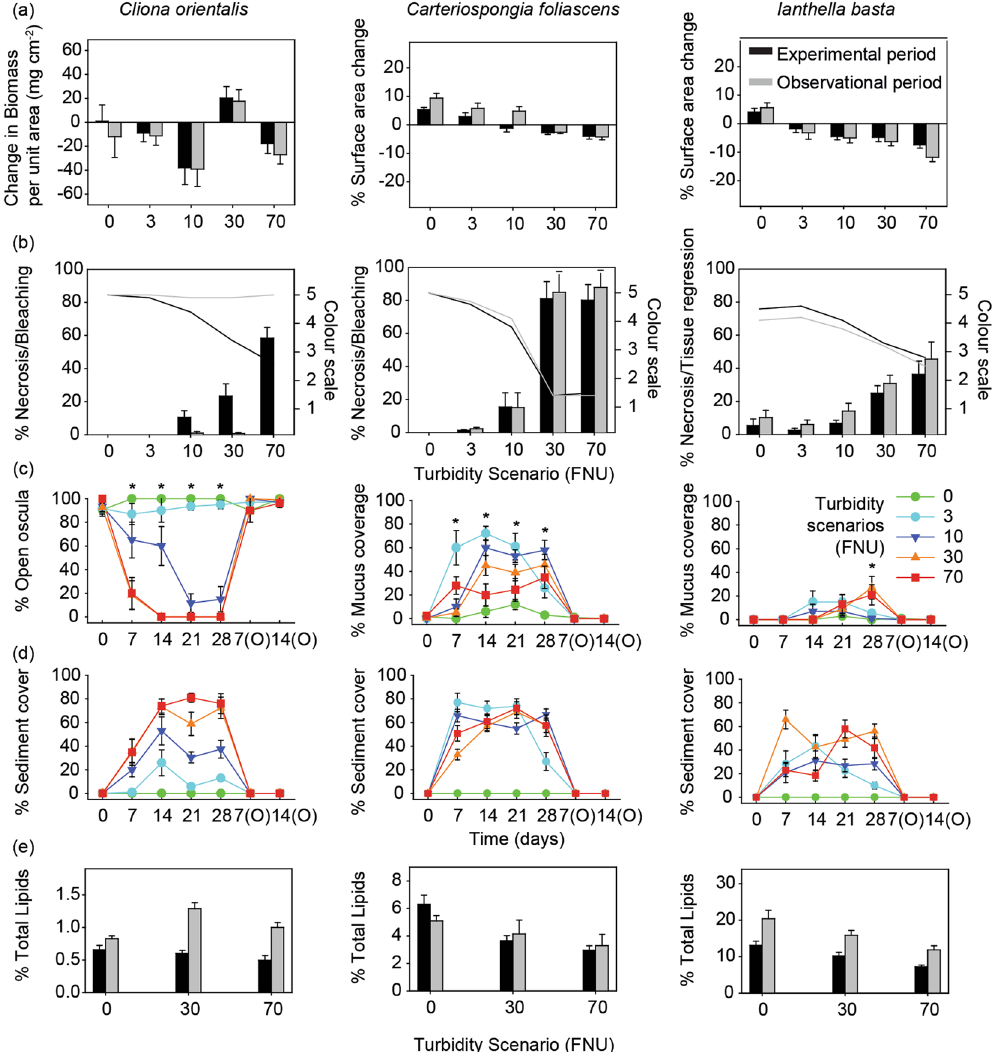
Figure 2. Sponge health, growth and behavioural responses. ( a ) Growth based on changes in biomass per unit area in C . orientalis (mg cm − 2 ) and percentage change in surface area in C . foliascens and I . basta , ( b ) percentage of necrotic, bleached, or regressed tissue (bars) and colour scale (lines), ( c) percentage of open oscula in C . orientalis and mucus production in C . foliascens and I . basta as stress responses to sediments, ( d ) percentage of sediment cover on sponges, and ( e ) percentage of sponge biomass comprised of lipids, for all species and targeted scenarios (0, 3, 10, 30 and 70 FNU) after the 28 d experimental period and 14 d observational period in a , b and e and throughout the experiment in c and d (mean ± SE). Asterisks in c show statistically significant differences between scenarios (ANOVA: P <